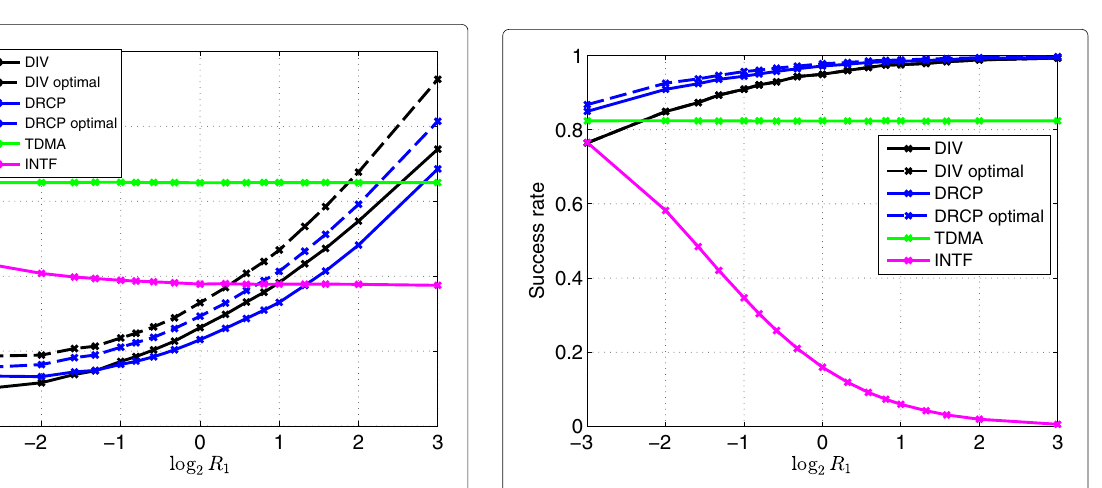
Fig. 8 Success rate of the studied approaches in the circuit power-dominated regime with S min 1 = S min 1 = 0.3